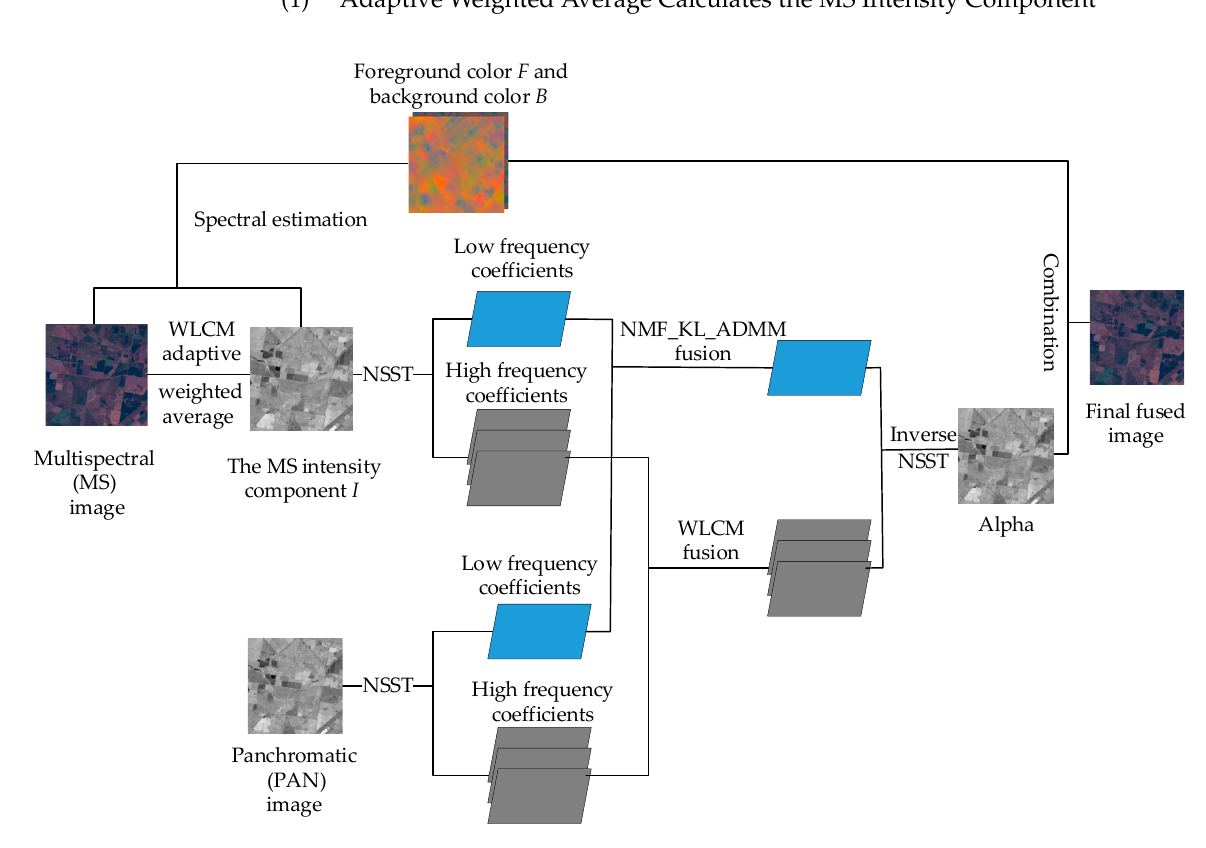
Figure 4. The flow chart of the proposed method. If a simple average fusion rule is adopted, the details of the original image will be